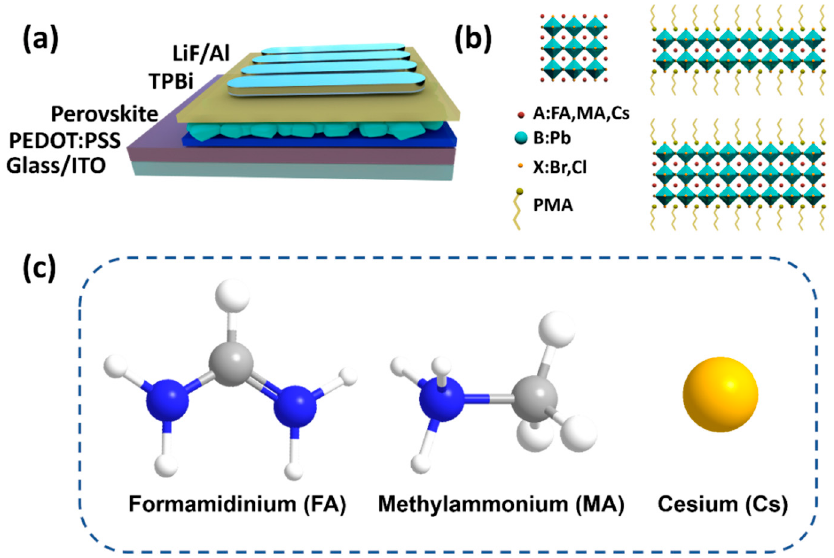
Figure 1. ( a ) Schematic illustration of quasi-2D perovskite light-emitting diodes (PeLEDs) architecture. ( b ) Schematic illustration of quasi-2D PMA 2 A 2 Pb 3 Br 8 Cl 2 (A = FA, MA, Cs) perovskite structure. ( c ) Schematic illustration of different cation structures.